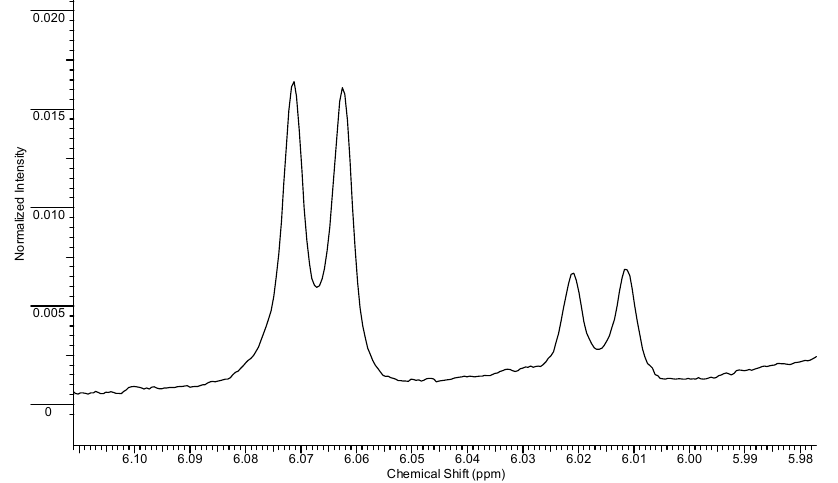
Figure 2. Spectral region between 5.97 and 6.10 ppm.